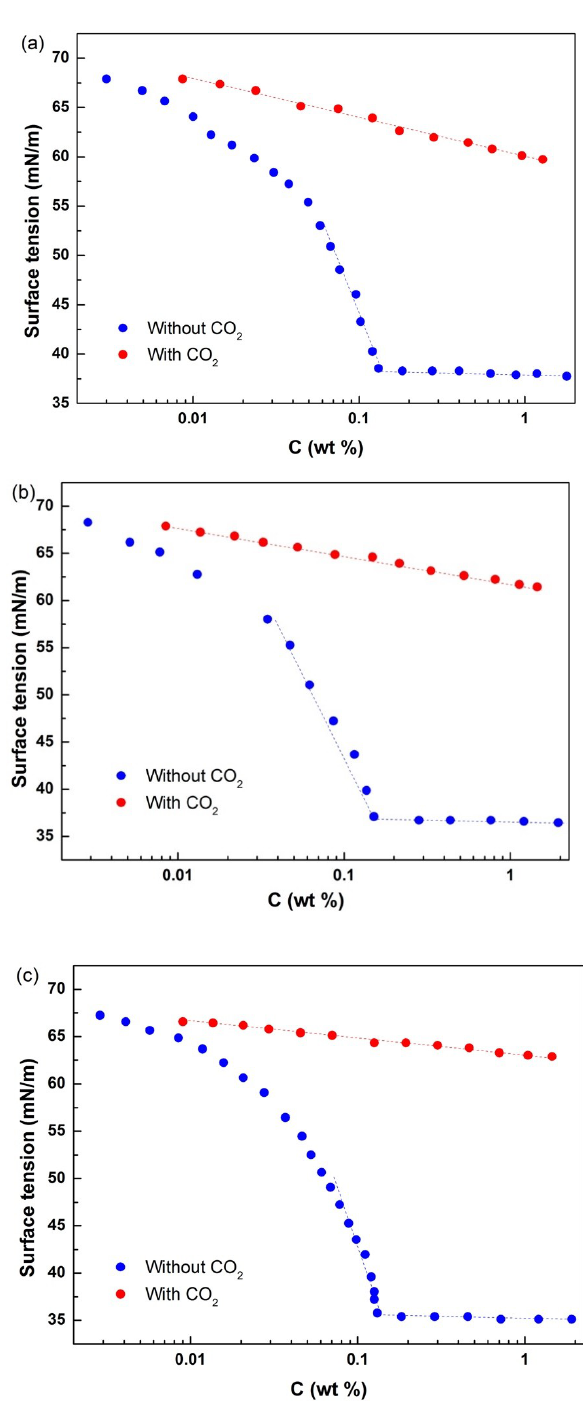
Figure 3. Surface tension of aqueous solutions containing copolymers 1 ( a ), 2 ( b ), and 3 ( c ) in the presence of air and CO 2 at 25 ± 0.5 °C.